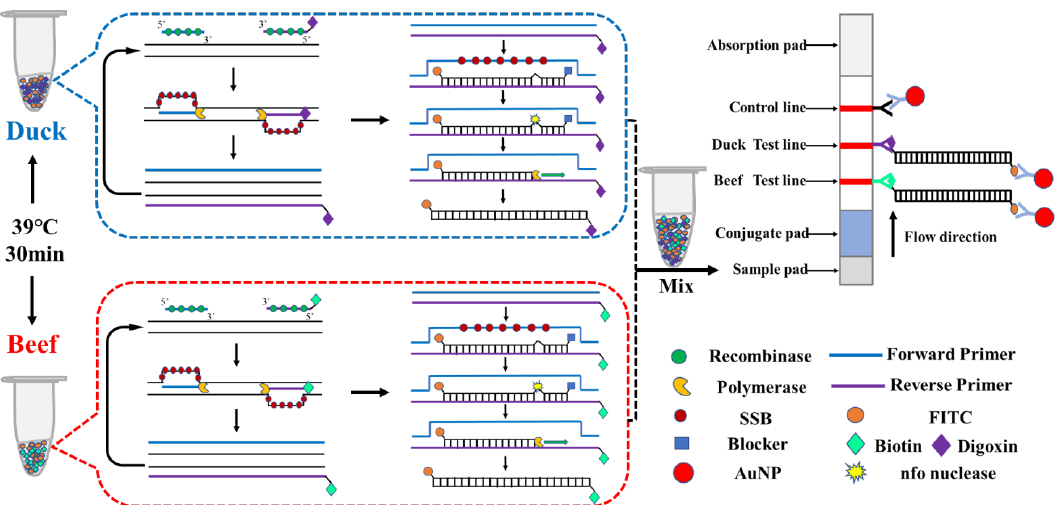
Figure 1. Recombinase polymerase amplification (RPA)–multiplex lateral flow dipstick (MLFD) assay. Firstly, the two oligonucleotide primers form a complex with the recombinase proteins. This complex is able invade the target DNA and directs the primer to homologous sequences. A continuous amplification at 39 ◦ C takes place by strand-displacement synthesis catalyzed by a DNA polymerase, while single-strand binding proteins (SSB) stabilize the displaced strand. Then biotin-labeled or digoxin-labeled nucleic acid amplification products could be hybridized with fluorescein isothiocyanate (FITC)-labeled specific probes. The nuclease nfo contained in the reaction solution recognized the abasic site and cleaved the phosphodiester bond to create a free hydroxyl end where DNA polymerase could extend and continue the amplification process. Finally, the dual-labelled amplicon for beef (biotin-RPA product-FITC) and duck (digoxin-RPA product-FITC) were generated. The mixed RPA amplification were dipped into lateral flow dipstick for MLFD detection.